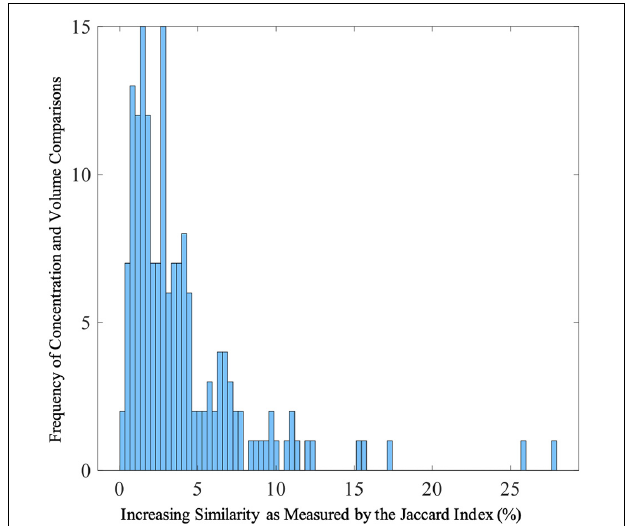
FIGURE 5 | Distribution of Jaccard Indices between Gray Matter Concentration and Volume Spatial Patterns Frequencies of Jaccard Indices showing similarities between gray matter concentration and volume spatial patterns. The range of Jaccard indices was 0.22–27.89% (SD = 4.04%) with a median of 2.73%. The Jaccard indices were calculated from thresholded ( z > | 2|) voxels that passed threshold.